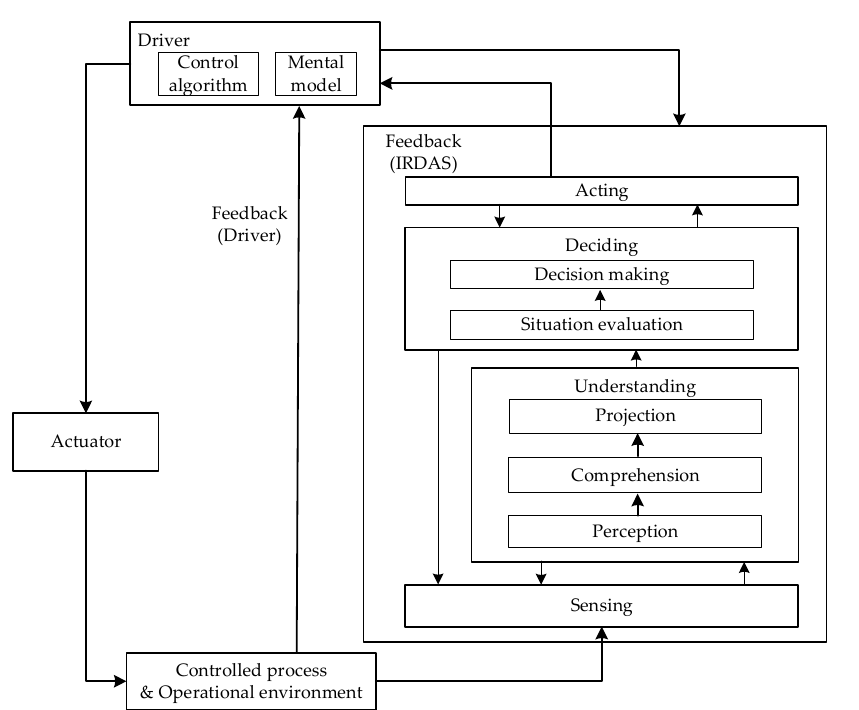
Figure 2. The customized control structure for the SOTIF of the IRDAS.